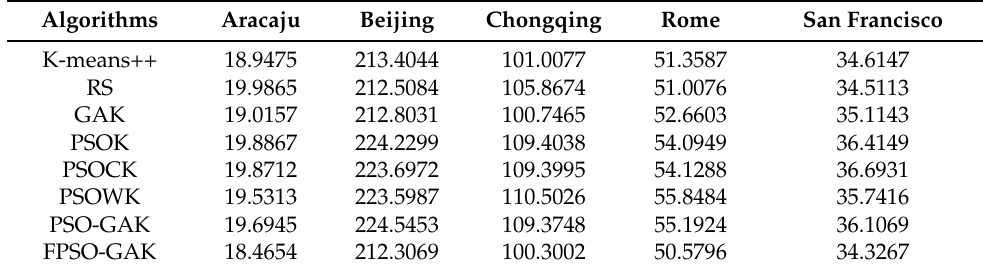
Table 7. Average SSE of 8 algorithms trained 20 times in 5 GPS data sets.